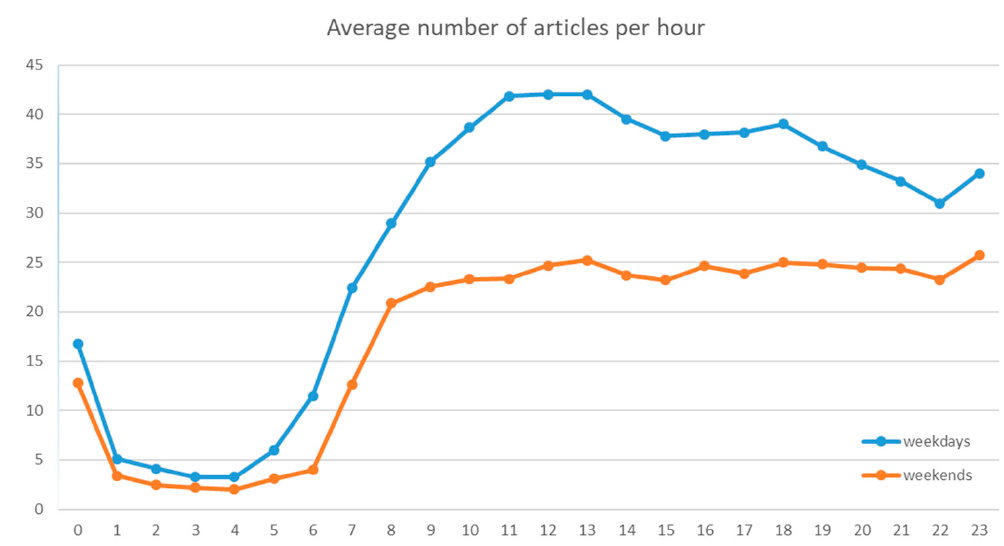
Figure 6. Average number of articles/hour (weekdays and weekends).